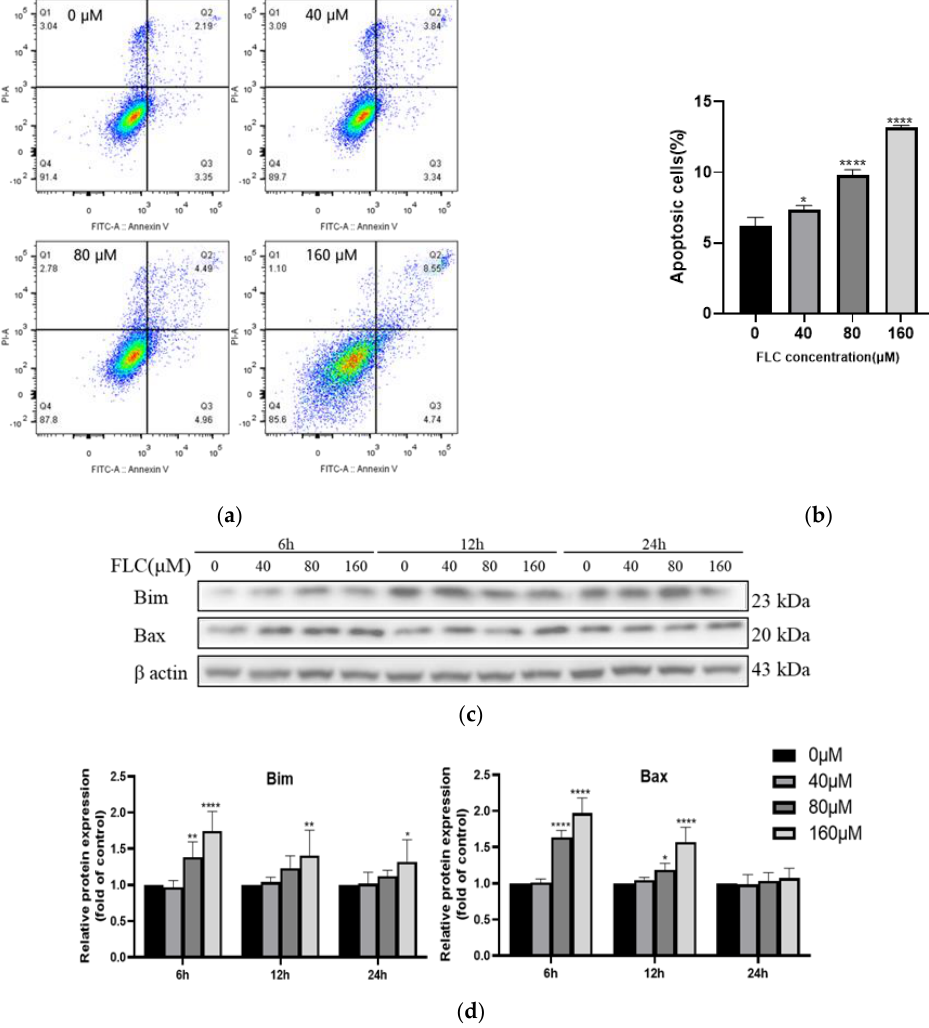
Figure 2. FLC induced apoptosis and altered up-regulated the level of pro-apoptotic proteins. TM4 cells were treated by FLC at the concentrations of 0, 40, 80, 160 μM for 6, 12, 24h. Apoptotic cells (6 h) were detected by flow cytometry and apoptosis protein levels (6, 12, 24 h) were determined by Western Blot with indicated antibodies. ( a ) The apoptotic cells were detected by Annexin V-PI double staining using Flow cytometer; ( b ) The quantitative data was analyzed by FlowJo and GraphPad Prism software ( n = 3); ( c ) The representative blots were shown; ( d ) The quantitative data was analyzed by ImageJ and GraphPad Prism software ( n = 6). * p < 0.05, ** p < 0.01,**** p < 0.0001 vs. control group (0 µ M